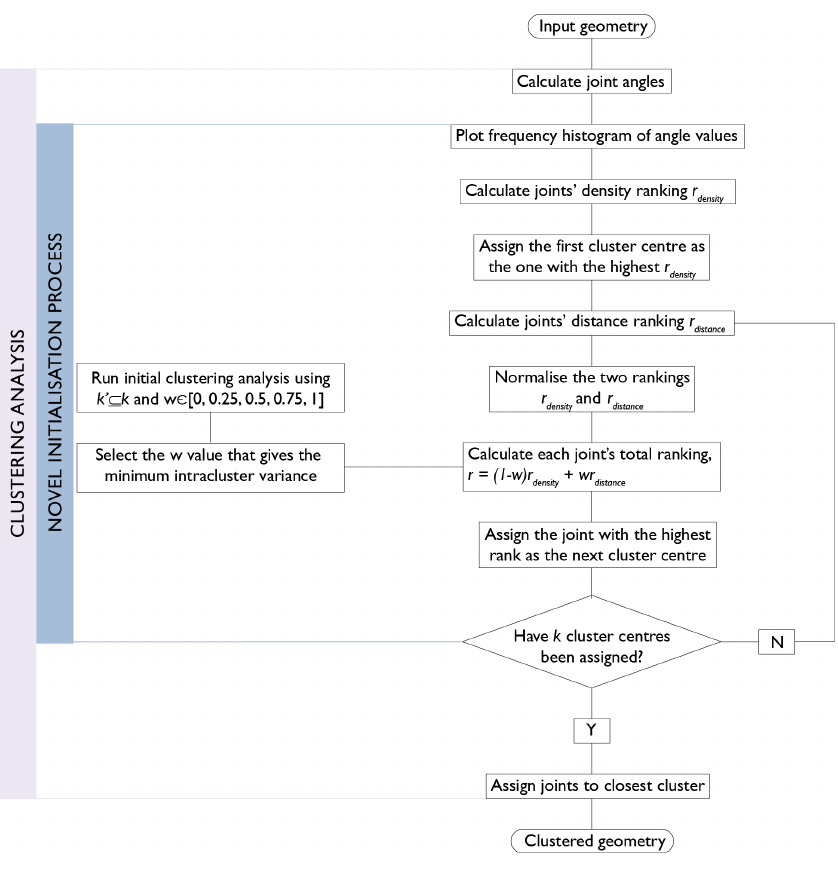
Figure 7. The pseudocode of the clustering analysis and the novel initialisation method.